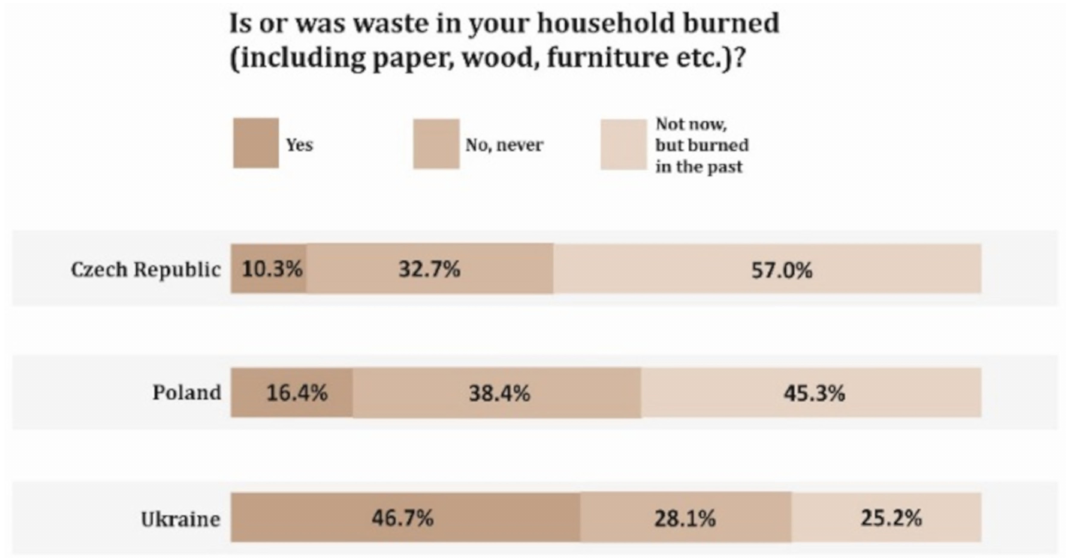
Figure 2. Burning paper, wood or plastic in households. Source: own study. A thermostat optimizes the cost of bills and unnecessary heat loss in the household. When asked about it to regulate the water or air temperature (Figure 3), the Czechs gave the highest percentage of positive answers, as over 52% of the respondents from this country have a thermostat installed. In the case of Poland and Ukraine, this percentage is 40%. In both of these countries, more respondents do not have a thermostat. The Czechs, on the other hand, showed the greatest lack of knowledge in this area. Almost every fifth respondent was unable to answer this question. Every seventh person showed a lack of knowledge in this respect, among both Poles and Ukrainians. The indicated differences in answers to the question turned out to be statistically significant (chi-square = 12.4, p -value <